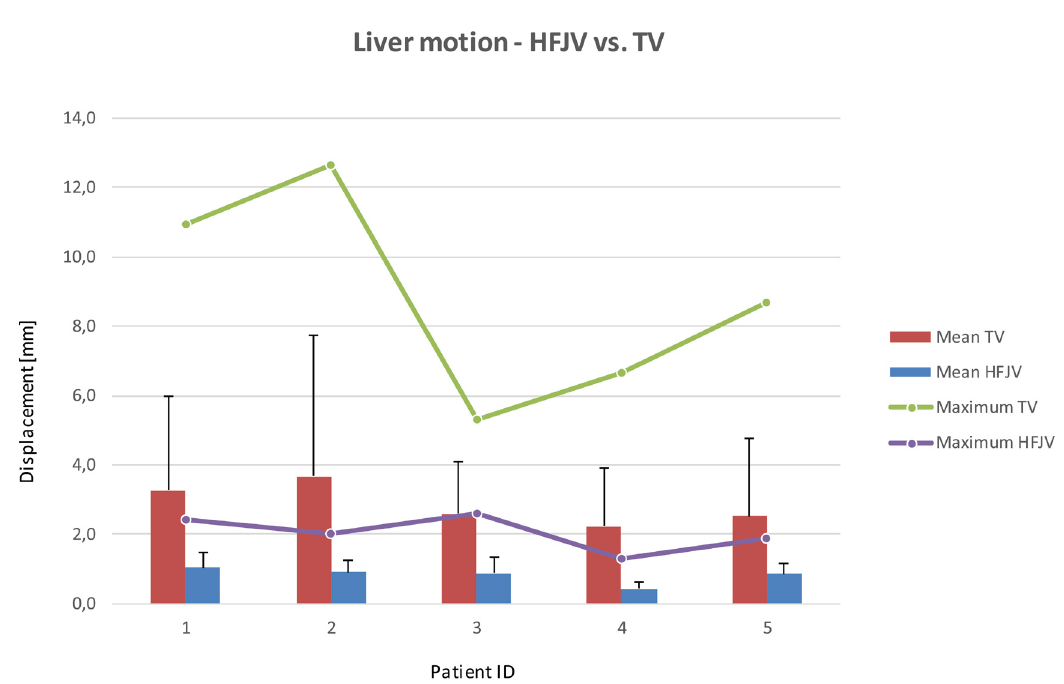
Figure 1. Liver displacement and lung ventilation. Displacement of measured point on liver surface during High-Frequency Jet Ventilation (HFJV) and standard ventilation (TV) Error bars mark standard